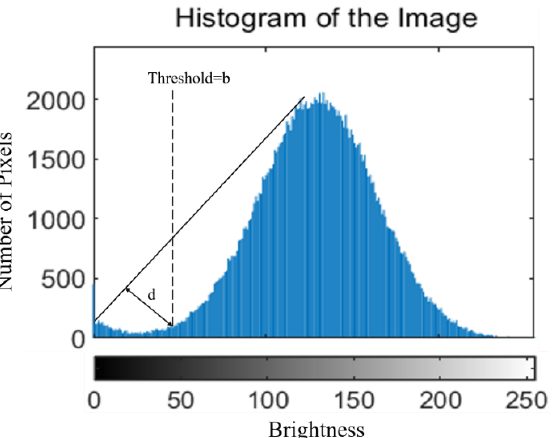
Figure 4. Determine the threshold geometrically using the histogram.